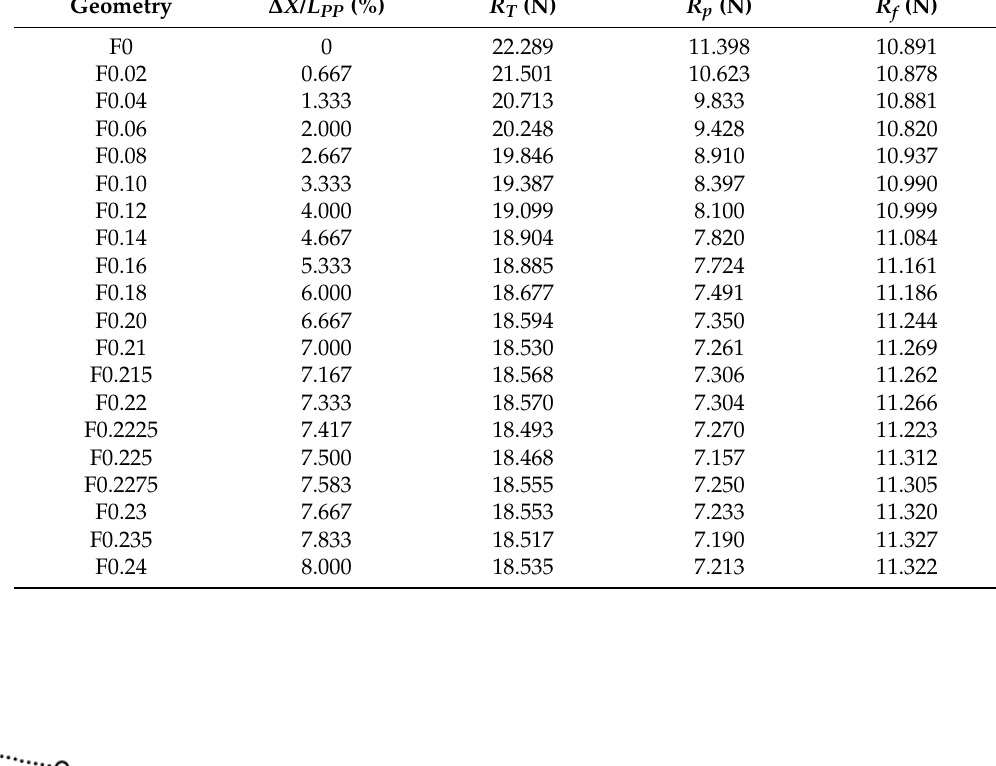
Table 4. V&V result for the ship’s total resistance R with F0 and F0.225 sonar dome.